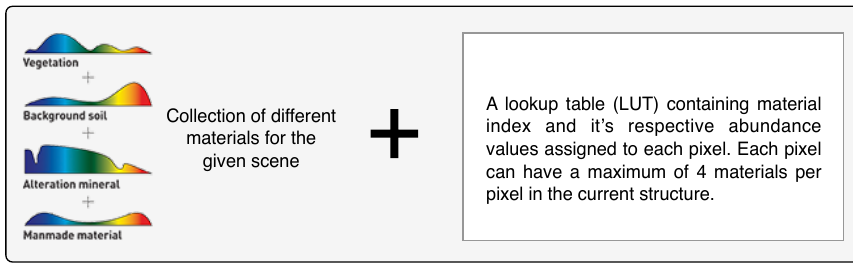
Figure 9. Structure of EM-abundance input used by a scene